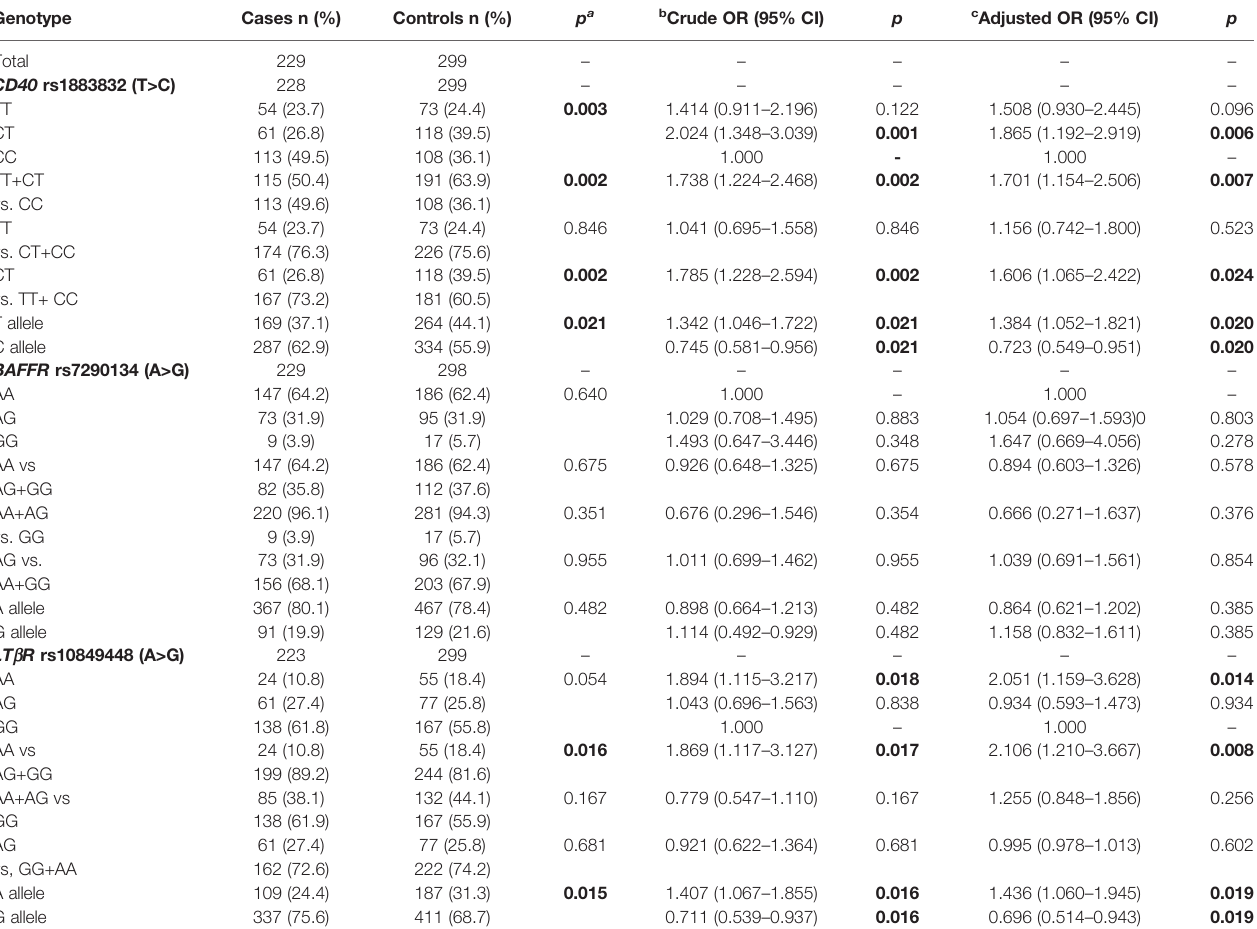
TABLE 9 | ORs and 95% CIs for NSCLC in relation to genotypes of studied SNPs.